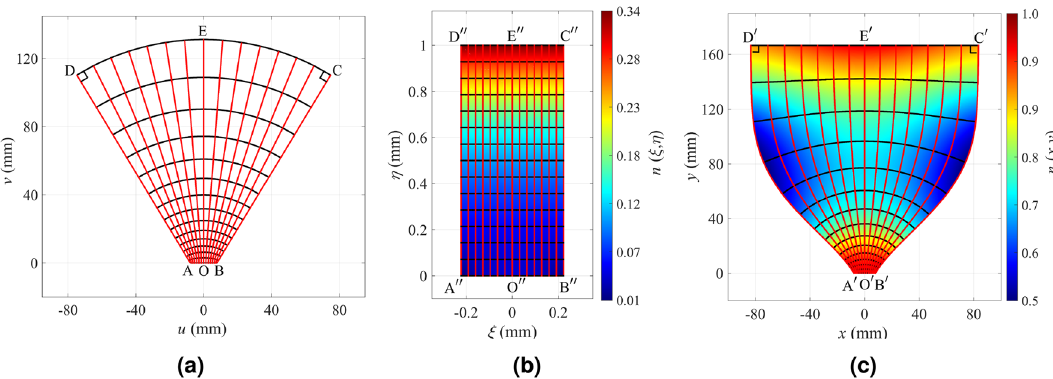
Figure 1. The schematics of ( a ) the virtual space, ( b ) the intermediate space and its refractive index, and ( c ) the physical space and its refractive index. The constant η and ξ coordinate lines in the intermediate space and their corresponding mapped images in the virtual and physical spaces are depicted by black and red lines,